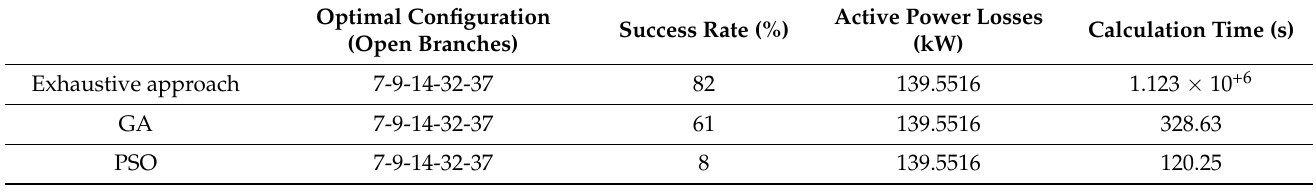
Table 2. Comparison between the proposed approaches for the minimization of the active power losses.